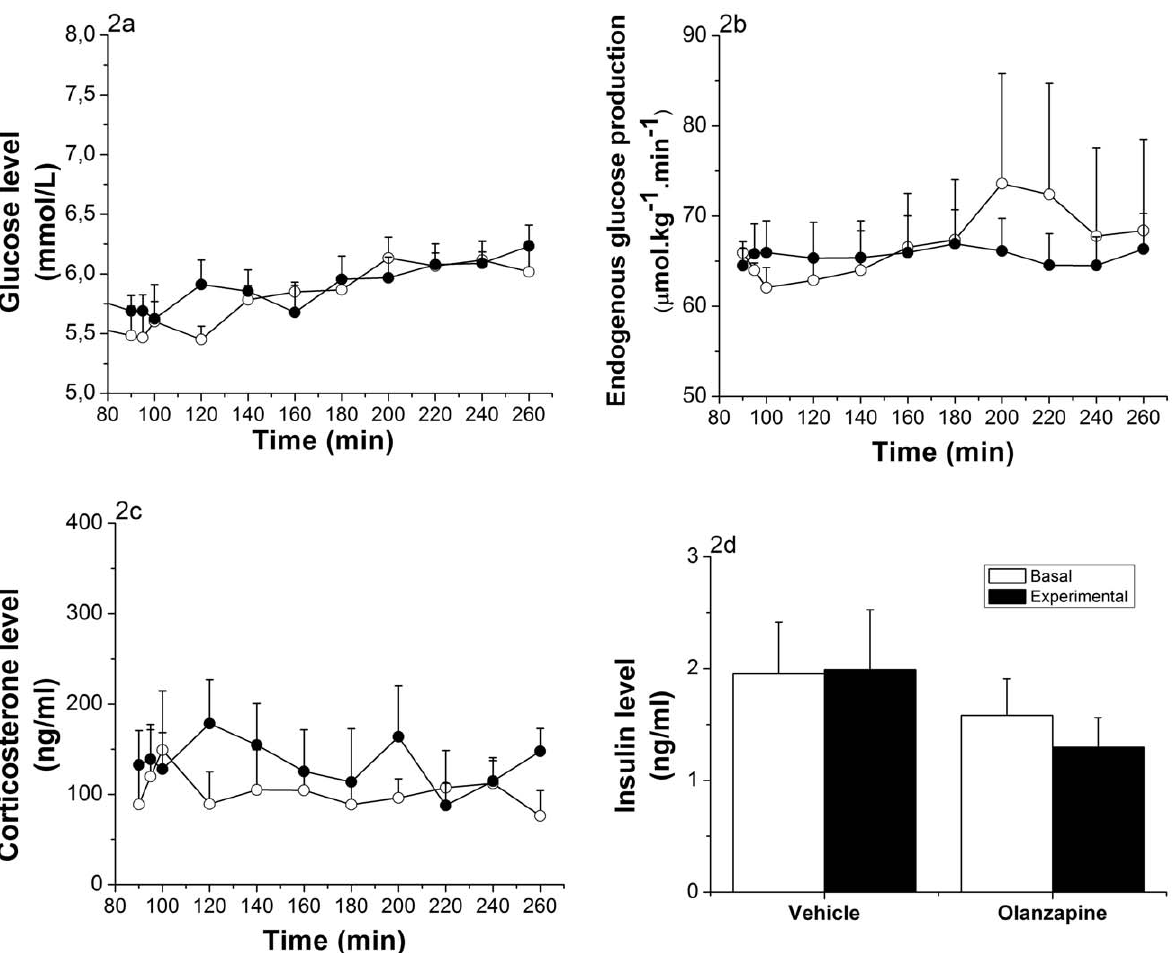
Figure 2. Effects of ICV infusion of Olanzapine. (Vehicle group n=6, Olanzapine group n=9). 2a: Glucose evolution before (t=90 to t=100) and during (t=120 to t=260) ICV Olanzapine infusion (30 m g/kg/h). No significant differences between the 2 groups were detected (ANOVA repeated measures; Time, p , 0.001; Time * Group, p=0.59; Group, p=0.635). 2b: Endogenous glucose production before (t=90 to t=100) and during (t=120 to t=260) ICV Olanzapine infusion. No significant changes were detected (ANOVA repeated measures; Time, p=0.731; Time * Group, p=0.709; Group, p=0.84). 2c: Corticosterone levels before (t=90 to t=100) and during (t=120 to t=260) ICV Olanzapine infusion. No significant changes were detected (ANOVA repeated measures; Time, p=0.971; Time * Group, p=0.631; Group, p=0.546). 2d: Plasma insulin levels before (mean of time points t=90 and t=100) and at the end (mean of time points t=220 and t=260) of the ICV infusion of Olanzapine. No significant changes were detected (ANOVA repeated measures; Time, p=0.722; Time * Group, p=0.638; Group, p=0.274). Vehicle-treated animals = white dots; Olanzapine-treated animals = black dots.